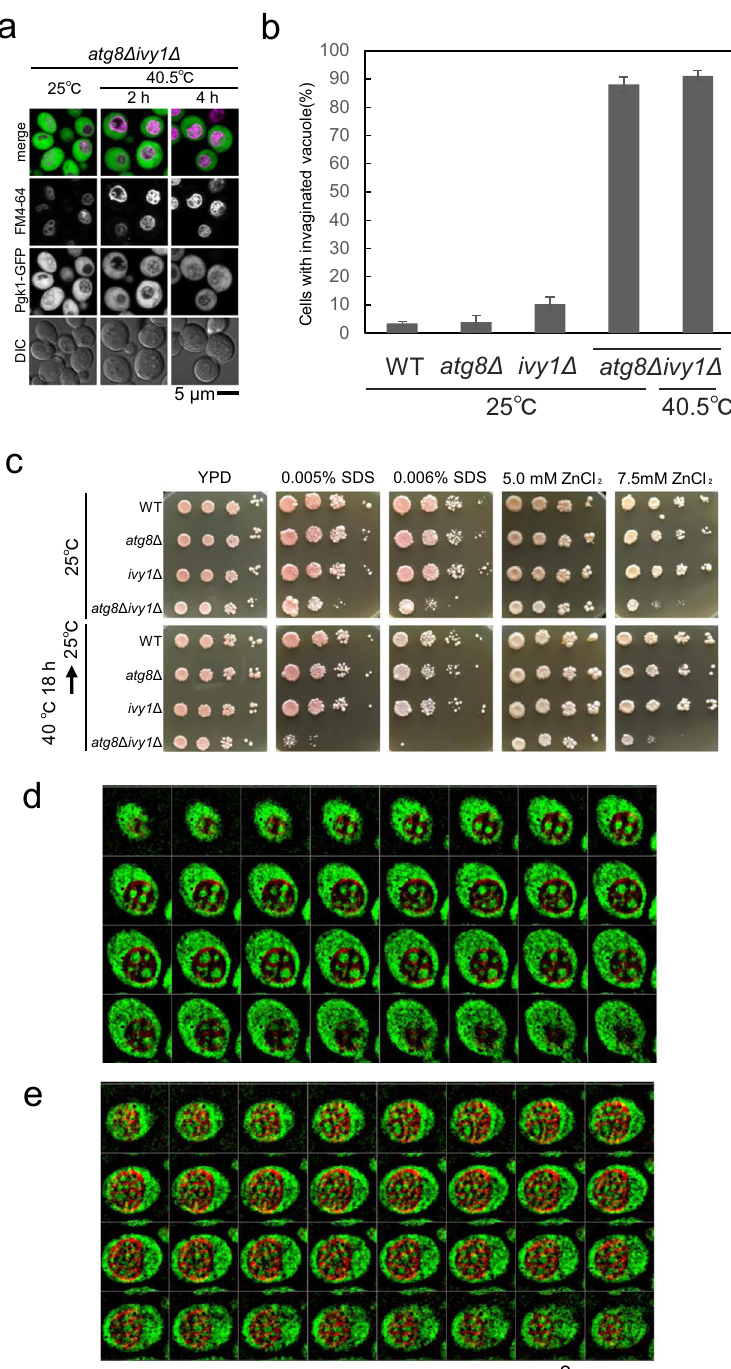
Figure 5. Relationship of Atg8 with Ivy1. ( a ) Enhanced vacuolar invaginations of atg8 Δ ivy1 Δ cells expressing Pgk1-GFP at 25 °C and 40.5 °C for 2 and 4 h. ( b ) Quantification of vacuolar invaginations of wild-type, atg8 Δ , ivy1 Δ , and atg8 Δ ivy1 Δ cells at 25 °C, and atg8 Δ ivy1 Δ cells at 40.5 °C for 4 h. The mean values of the ratio and standard errors (SE) are shown. ( c ) Sensitivities against SDS and ZnCl 2 . Serial 10-fold dilutions of indicated strains grown at log phase were spotted on YPAD, YPAD + 0.005% SDS, YPD + 0.006% SDS, YPAD + 5.0 mM ZnCl 2 , and YPAD + 7.5 mM ZnCl 2 plates. Cells were placed at 25 °C or at 40 °C for 18 h followed by the incubation at 25 °C. Cells were incubated at 25 °C for 3 days for YPAD, 6 days for SDS-containing cells, and 8 days for ZnCl 2 containing plates. ( d , e ) Z-stack analysis (0.1 μ m spacing) of FM4-64 treated atg8 Δ ivy1 Δ mutants expressing PGK1-GFP with ( e ) or without 0.006% SDS ( d ) for 3 h at 25 °C. Merged images of GFP and FM4-64 fluorescence are shown. Scale bar, 2 μ m. The images were taken by